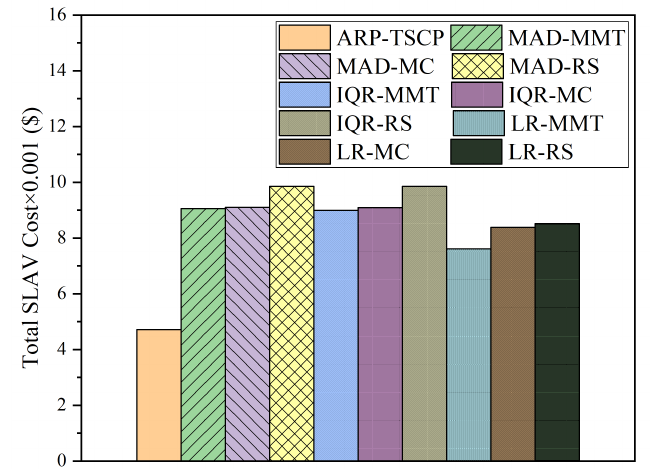
Figure 13. Comparing the total SLAV penalty cost by all